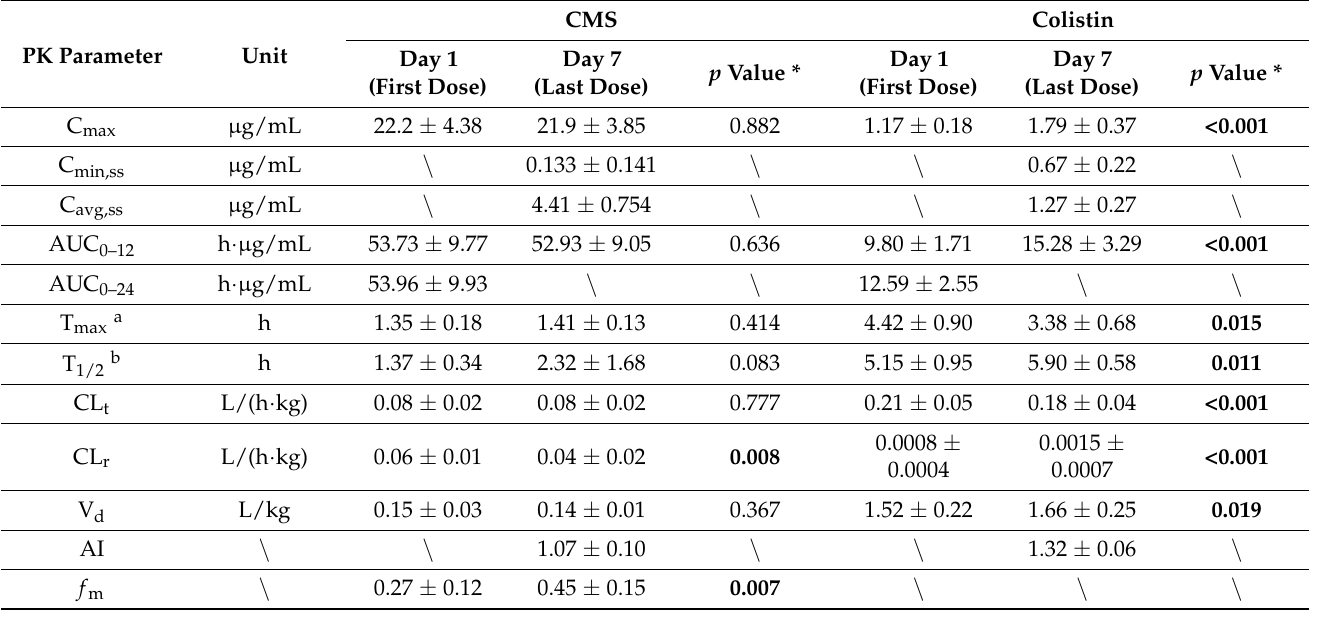
Table 1. Summary of pharmacokinetic parameters in healthy Chinese subjects after multi-dose intravenous infusions of CMS (mean ± SD, n = 12).